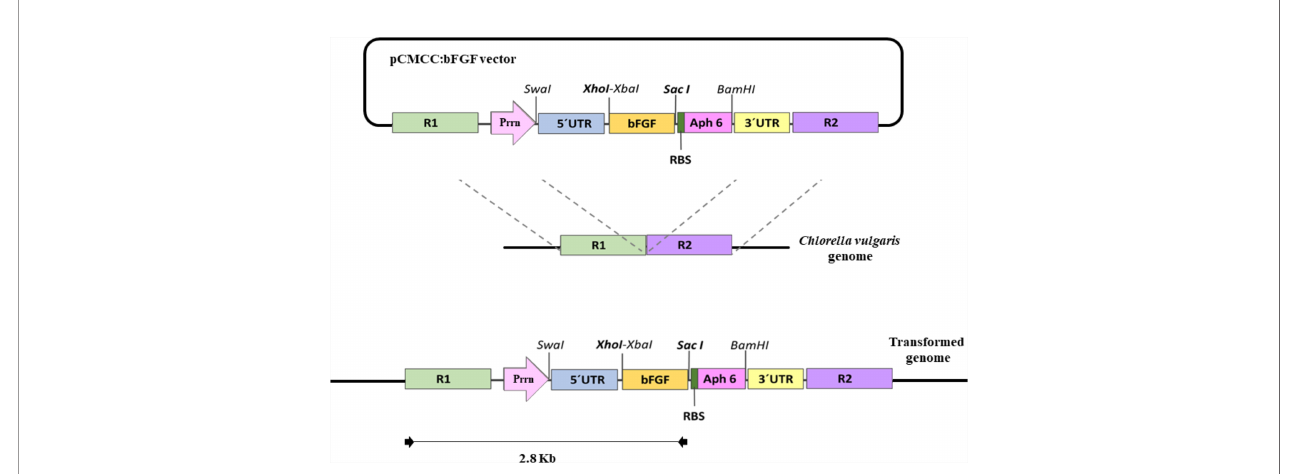
FIGURE 1 | Diagrammatic representation of the pCMCC:bFGF vector. R1, recombination region comprising 16S rRNA gene and TrnI genes from Chlorella vulgaris genome (NC_ 001865.1); Prrn , promoter region from Prrn gene from Chlamydomonas reinhardtii ; Swa I, restriction enzyme site; T7 5 ′ UTR, 5 ′ untranslated region from gene 10 of T7 phage; Xho I /Xba I, restriction sites for the cloning gene of interest; bFGF, encodes the human bFGF along with His-tag at the N-terminus end; Sac I, restriction site for cloning the gene of interest; Aph6 , selectable marker gene conferring resistance to kanamycin; Bam HI, restriction enzyme site; 3 ′ psb A, UTR at the 3 ′ end from psbA gene; R2, recombination region from the C. vulgaris genome (NC_ 001865.1) comprises the genes for TrnA , ORF64, ORF41a, and ORF74 and a part of the 23S rRNA gene. The ampli fi ed sequences using speci fi c primers are marked with